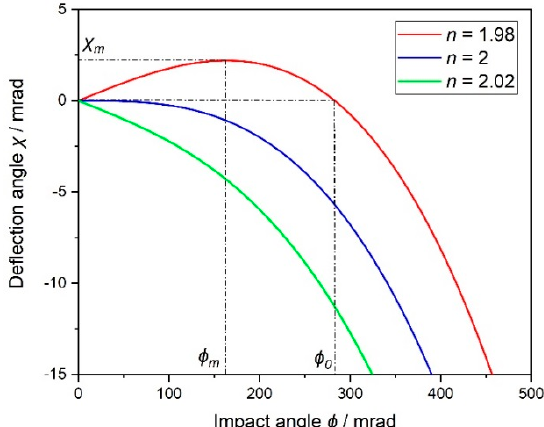
Figure 4. Transfer function for incident and reflected rays of different refractive indices n (the red curve is the most representative for our situation); as soon as a ray moves away from Z axis, increasing its impact parameter b , the deflection angle increases in this way: from a null value, it reaches a maximum in correspondence of φ m , then it starts decreasing until a null value (parallel to itself but mapped in the other half-space) when φ = φ 0 . Image inspired by [5] (Figure 3).